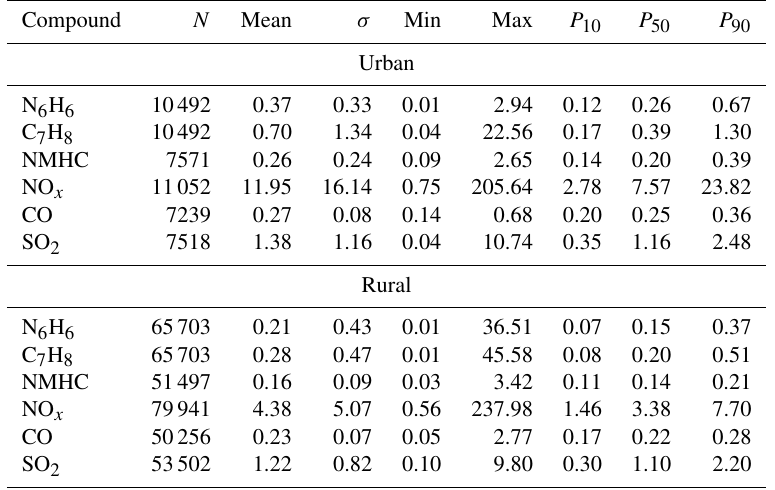
Table 5. Surface levels of the studied impurities in urban and rural areas along the Trans-Siberian Railway. All impurities are in ppb except for NMHC and CO (ppm).